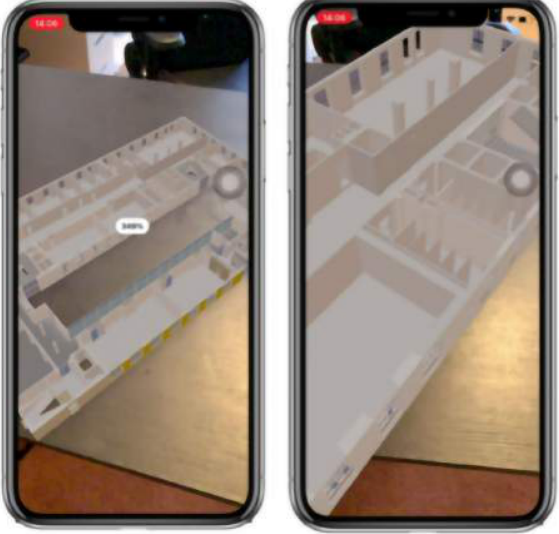
Figure 6. AR Application for Building